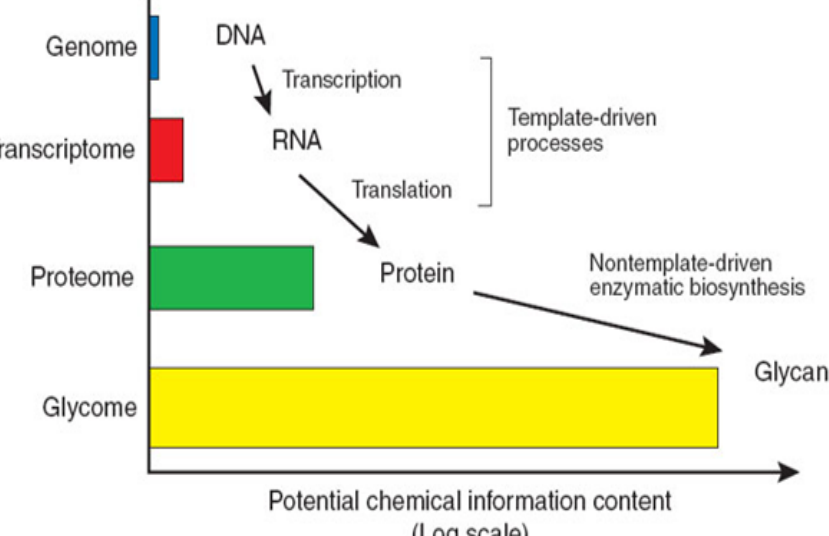
Figure 1. The complexity of the glycome. The glycome is defined as the complete set of glycan structures expressed at a particular time and spatial position in specific cells, tissues or organisms. Therefore the complexity of structures and the potential chemical information of the glycome far exceed that of the genome and proteome. Figure taken from